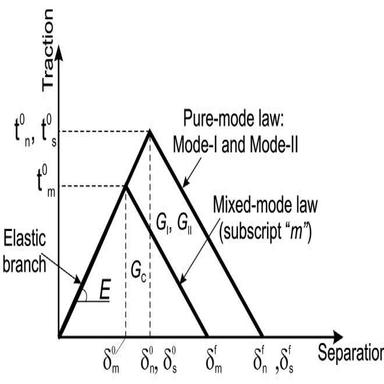
Bilinear traction-separation law in Cohesive Zone Model available in Abaqus® .